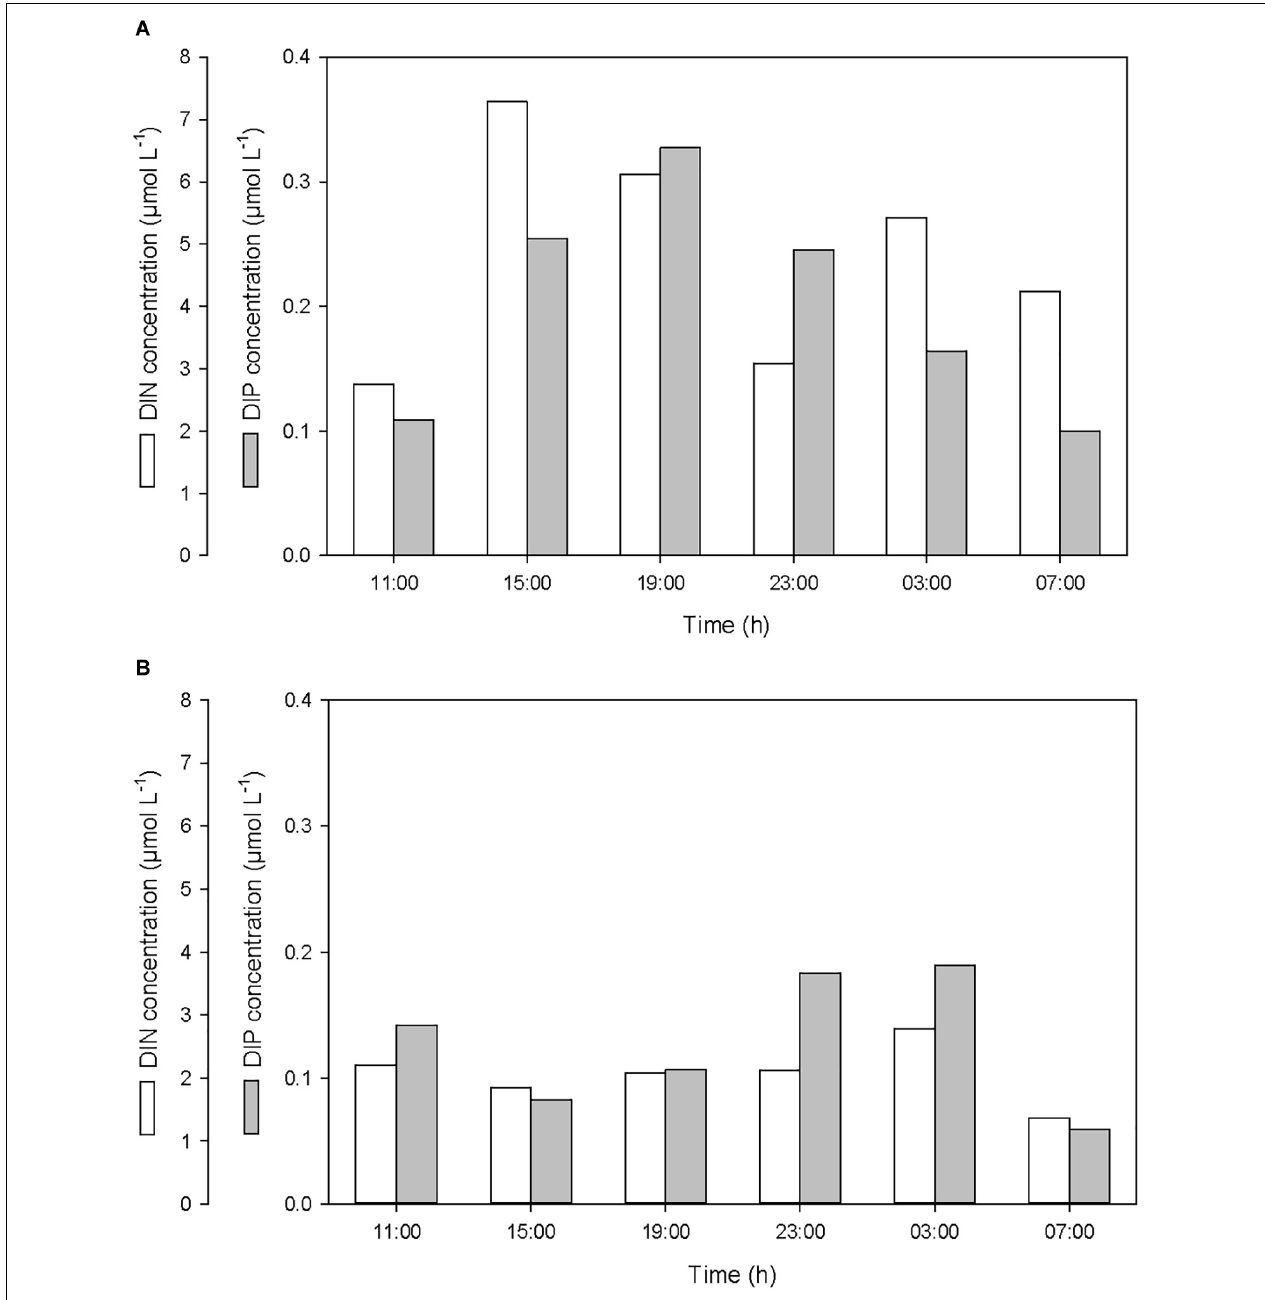
FIGURE 6 | Variations of dissolved inorganic nitrogen (DIN) and phosphorus (DIP) concentrations (A) in the SML and (B) in the